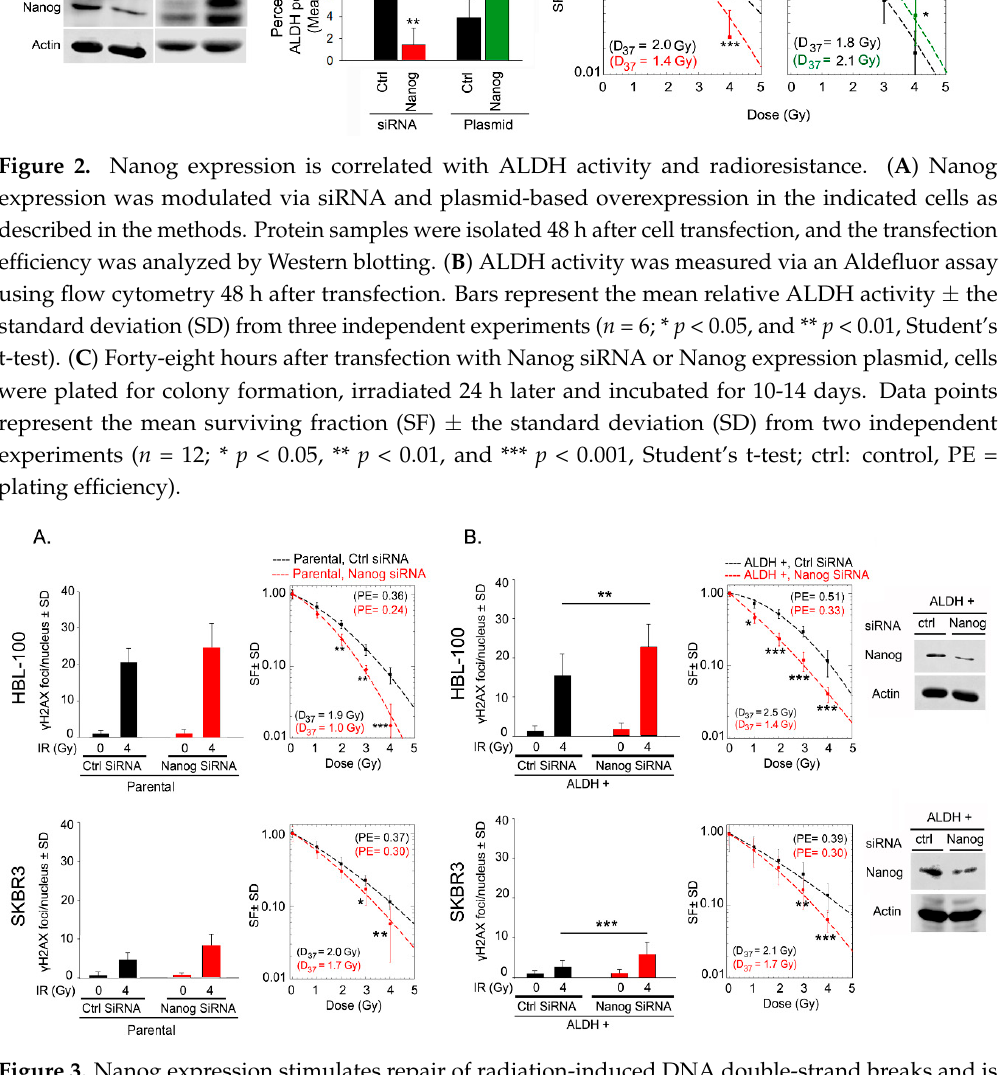
Figure 3. Nanog expression stimulates repair of radiation-induced DNA double-strand breaks and is associated with the radioresistance of ALDH-positive cells. ( A ) and ( B ) Parental and ALDH-positive sorted cells were transfected with 50 nM control (ctrl) or Nanog siRNA and exposed to 4Gy irradiation 48 h after transfection. Twenty-four hours after irradiation, residual γ -H2AX foci were counted in irradiated and nonirradiated cells. Nanog siRNA-transfected cells were seeded for colony formation assessment and irradiated 24 h later. Survival curves were prepared based on two independent experiments ( n = 12; * p < 0.05, ** p < 0.01, and *** p < 0.001, Student’s t-test). Protein samples were isolated, and knockdown efficiency was tested by Western blotting.